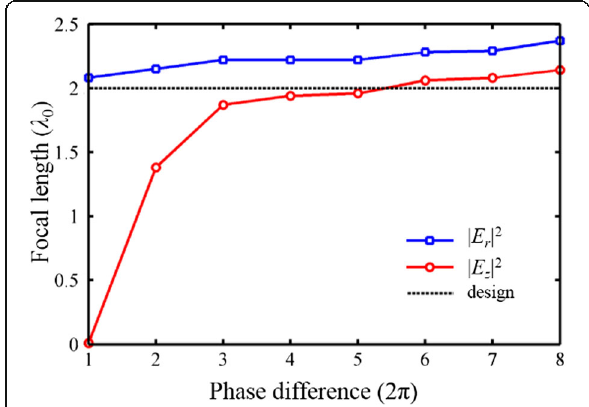
Fig. 13 The focal length of the NRPL with the increase of total phase difference from 2 π to 16 π